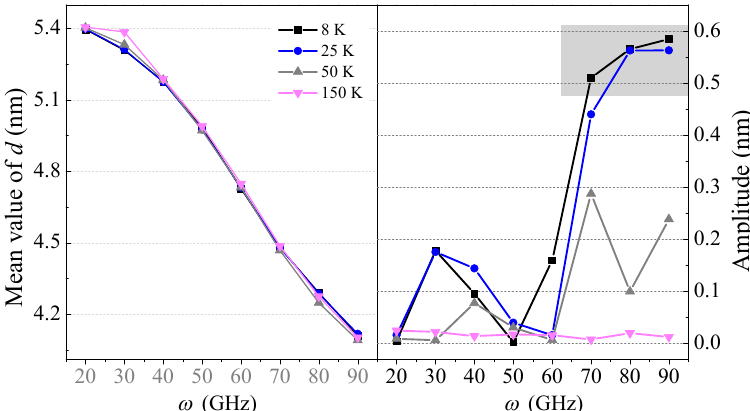
Figure 5. Mean values and amplitudes of d curves of the Z2H6 system between 9 ns and 10 ns at different temperatures.